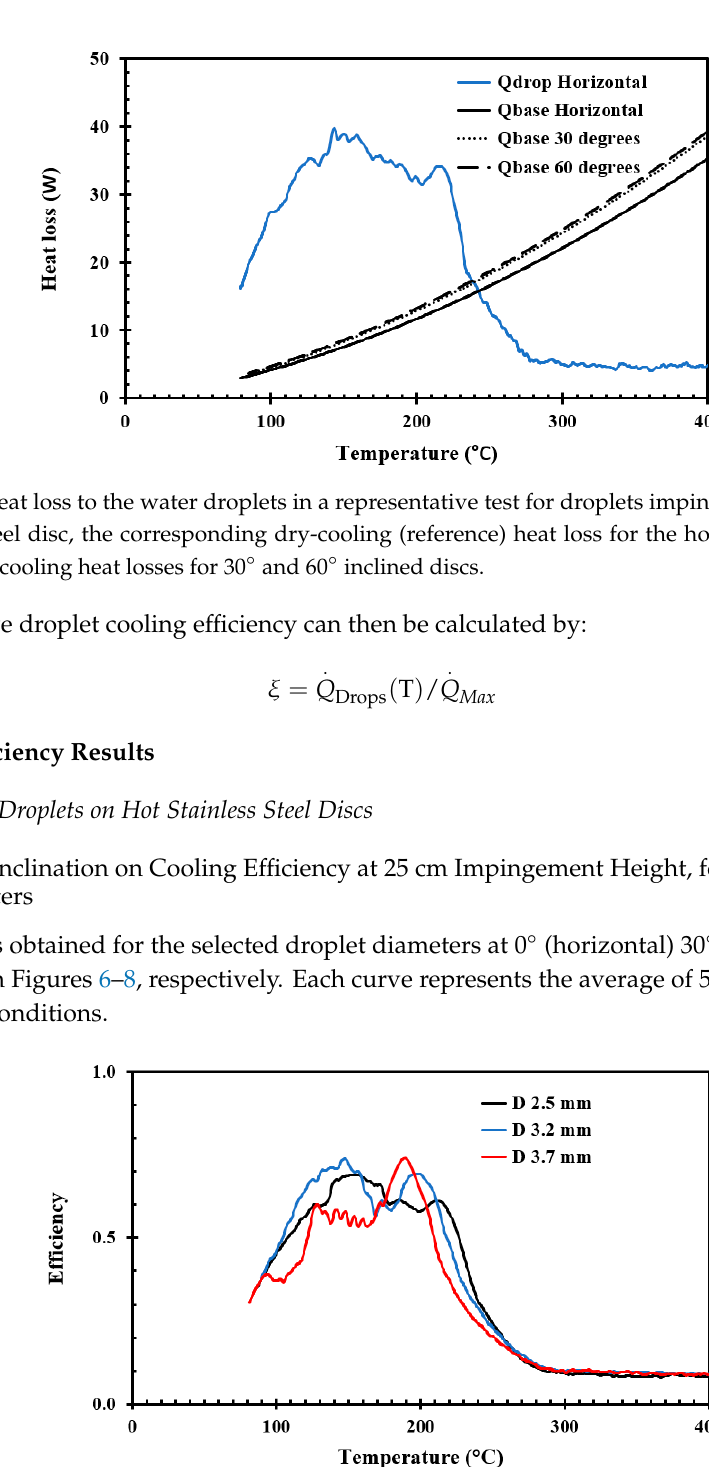
Figure 6. Cooling efficiency for pure water droplets with 25 cm impingement height for horizontal orientation and various droplet diameters. Droplet speed 2.2 m/s.